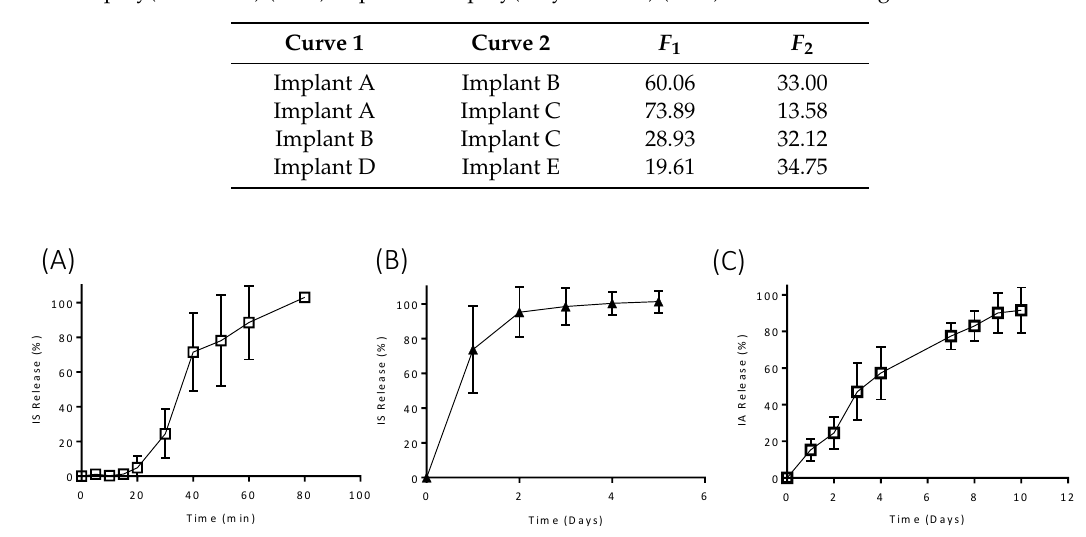
Figure 7. Release of ( A ) ibuprofen sodium (IS) from Implant B; ( B ) IS from Implant E and ( C ) release of ibuprofen acid (IA) from Implant B ( n = 3, means ± SD).